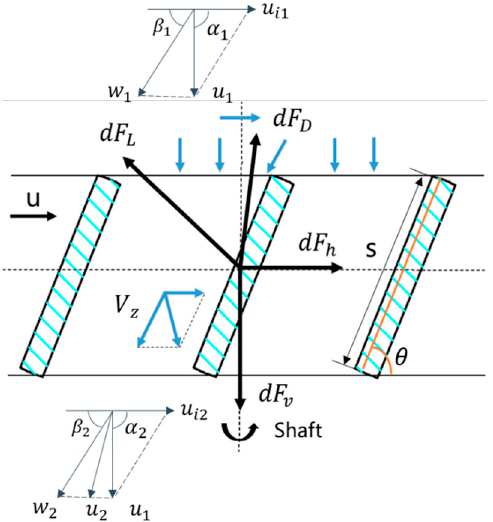
Figure 3. Schematic diagram of the force of the passive motion of the turbine.